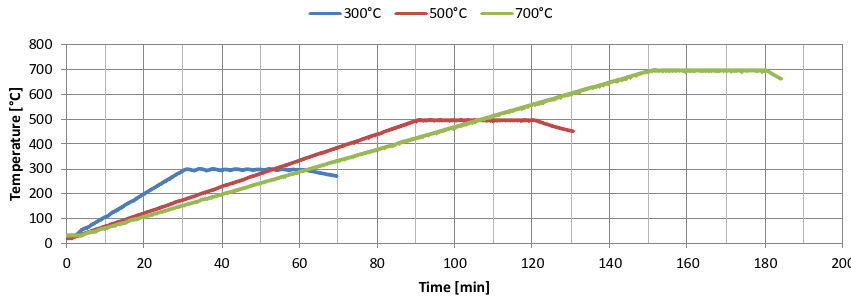
◦ C Heating Curve.